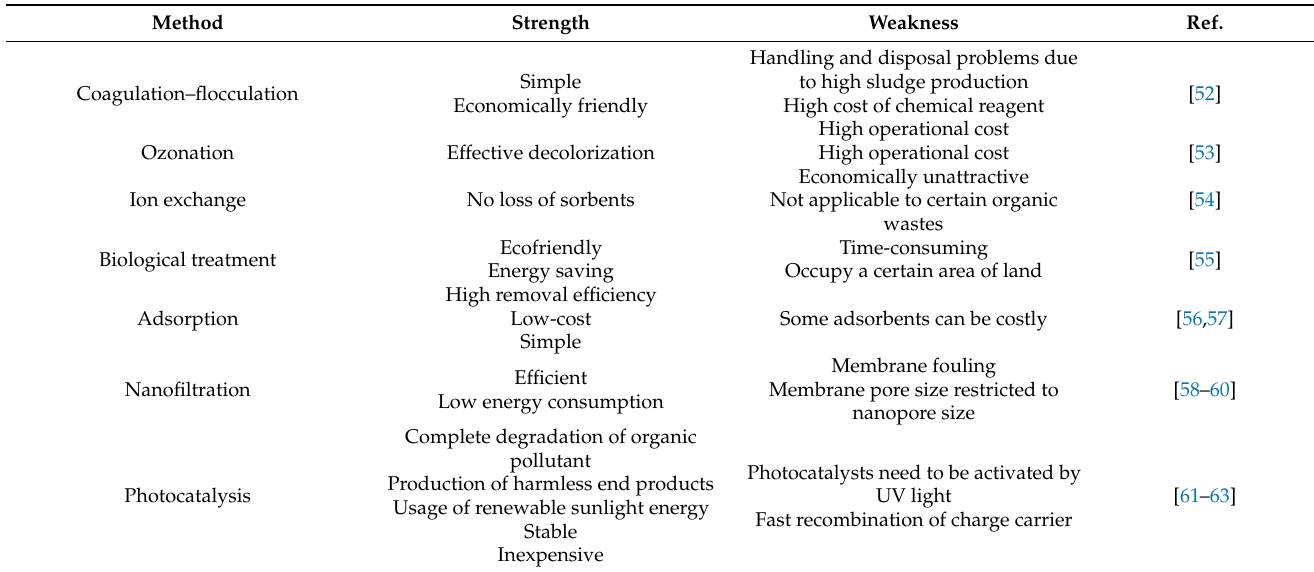
Table 3. Strengths and weaknesses of various methods for organic waste